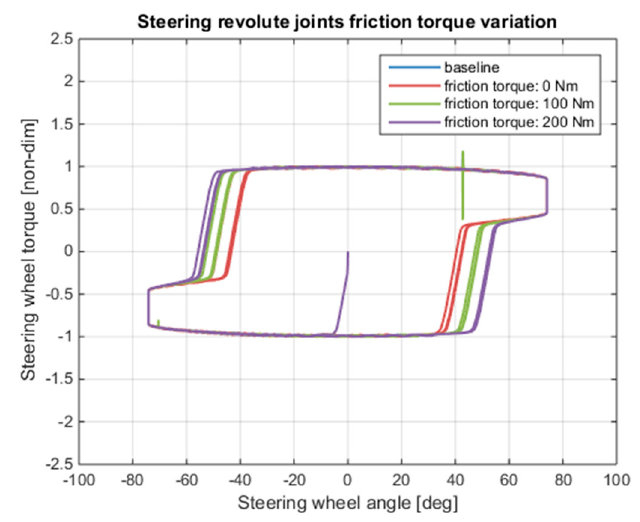
Figure 16. Steering wheel torque-angle curve for different values of friction at the revolute joints of the steering mechanism.